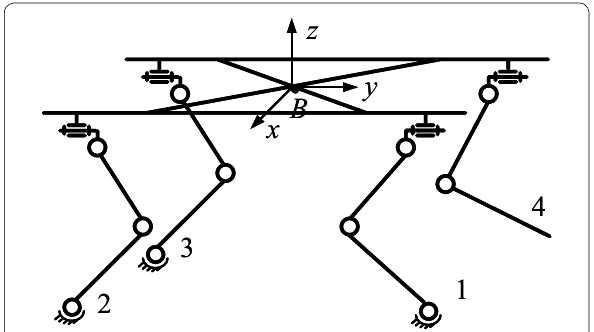
Figure 3 Equivalent mechanism of robot with three stance